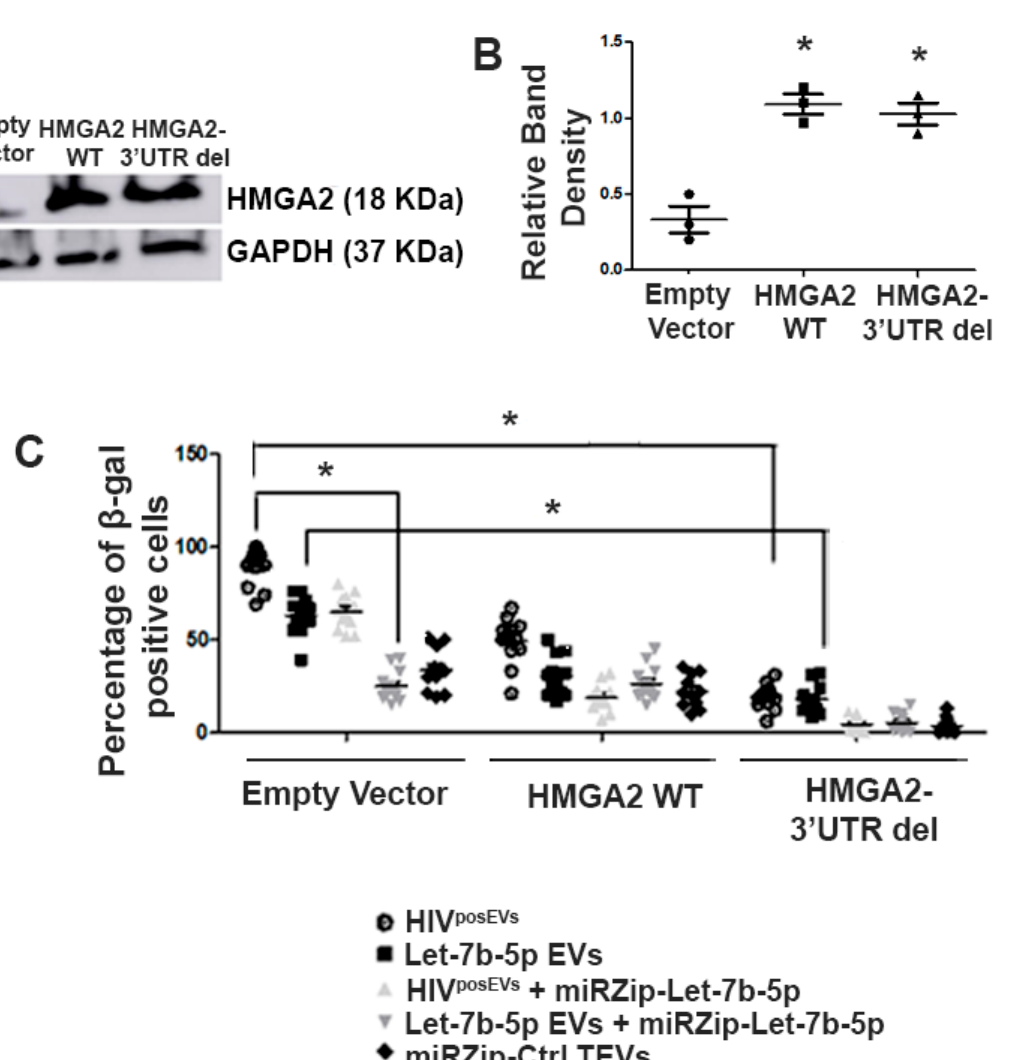
Figure 7. Hmga2 with 3 (cid:48) UTR deletion attenuates HIV posEVs effect in lin − BMC senescence. ( A , B ). Ex- pression and quantification of Hmga2 in lin − BMCs transduced with different expression vectors. ( C ). Cellular senescence is measured by β -gal staining. Let-7b EVs partially recapitulate the effects of HIV posEVs on lin − BMCs. In Hmga2-3 (cid:48) UTRdel-overexpressing lin − BMCs, the effects of HIV posEVs on β -gal expression were partially blocked, similar to co-incubation with miRZip-let-7b-5p TEVs, whereas Hmga2-3 (cid:48) UTRdel overexpression almost completely blocked the effects of let-7b EVs. Fur- thermore, wt Hmga2 overexpression modestly attenuated the effects of HIV posEVs and let-7b EVs. The experiments were performed in triplicate and repeated thrice. Statistical tests used: Kruskal–Wallis and Dunn’s Multiple Comparison Test as a post test. Representative images for the β -gal experiment are available in the Supplementary Materials (* p <